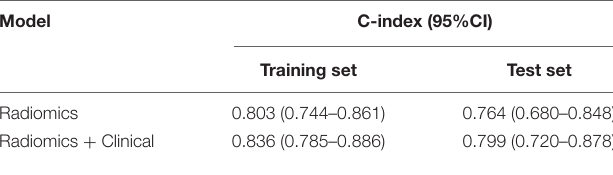
TABLE 4 | Comparison of the predictive performance of the models using the C-index in the training and test